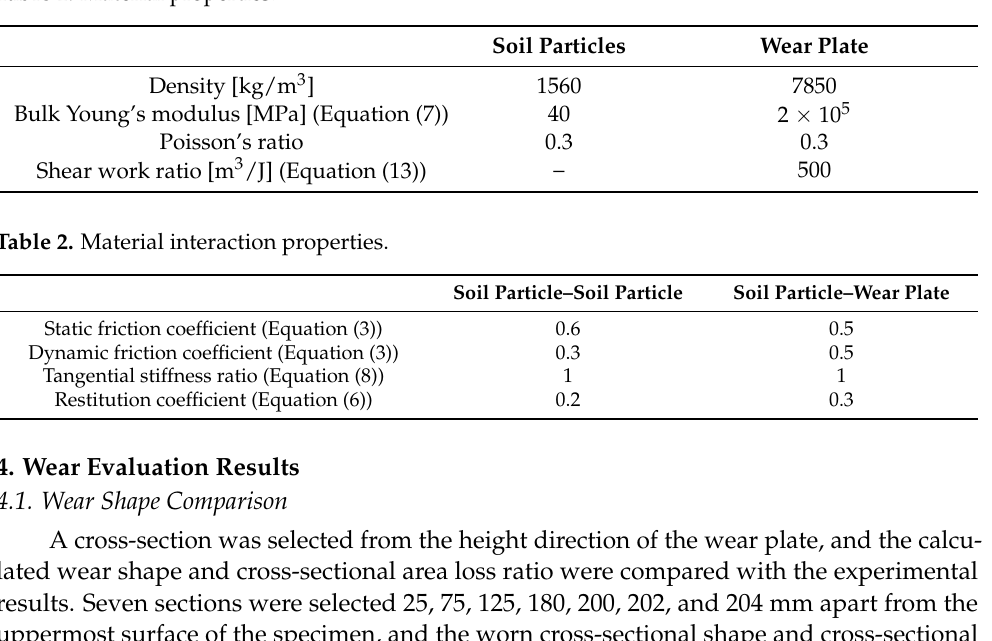
Table 1. Material properties.